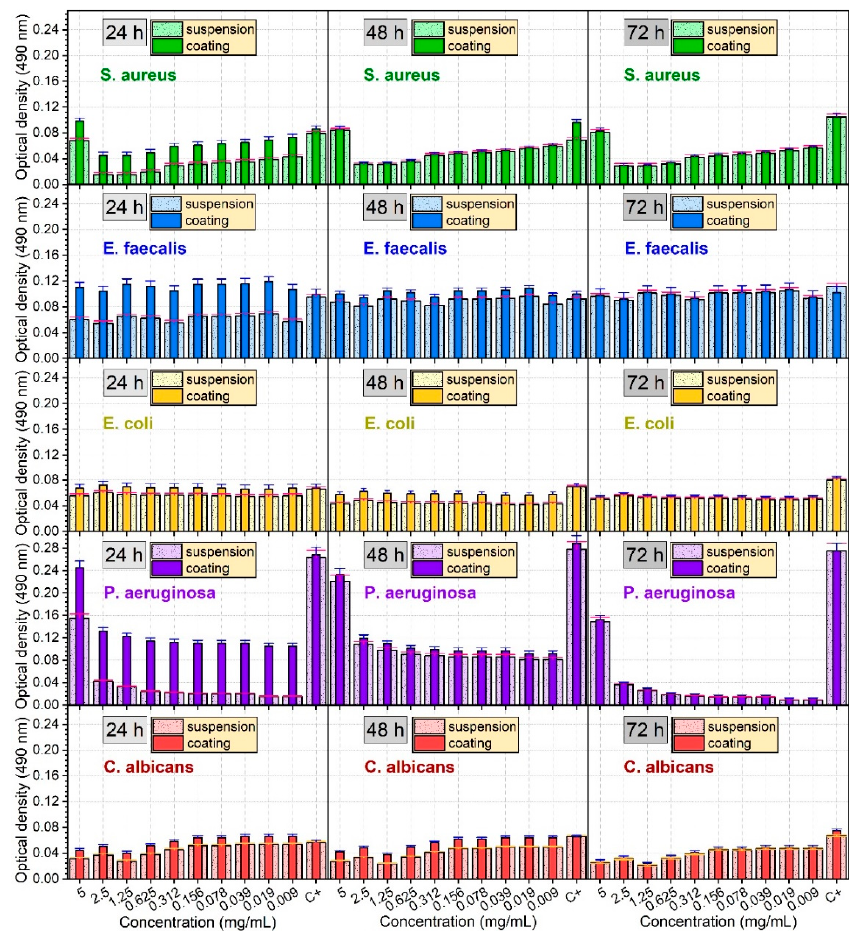
Figure 11. The dynamics of the antimicrobial activity of 10MgHAp-Dex-thyme suspension and coating against S. aureus (ATCC ® 25923), E. faecalis (ATCC ® 29212), E. coli (ATCC ® 25922), P. aeruginosa (ATCC ® 27853), and C. albicans (ATCC ® 90029) microbial cells after 24, 48, and 72 h of incubation. The safety and stability of the dextran-thyme coated magnesium-doped hydroxyapatite particle suspension make it a highly interesting nano-system for many biomedical applications.